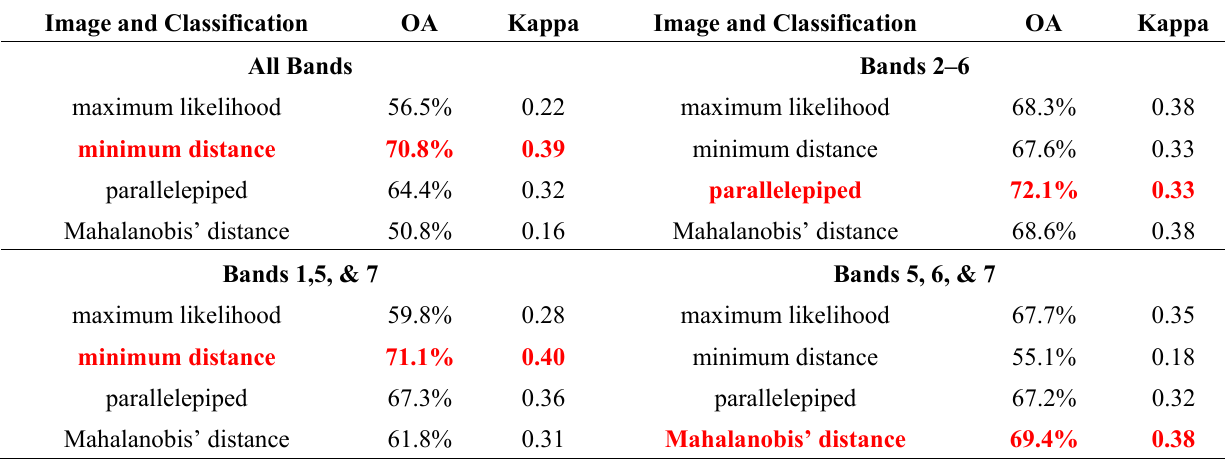
Table 4. Overall accuracy (OA) and kappa of all sixteen classified Landsat images